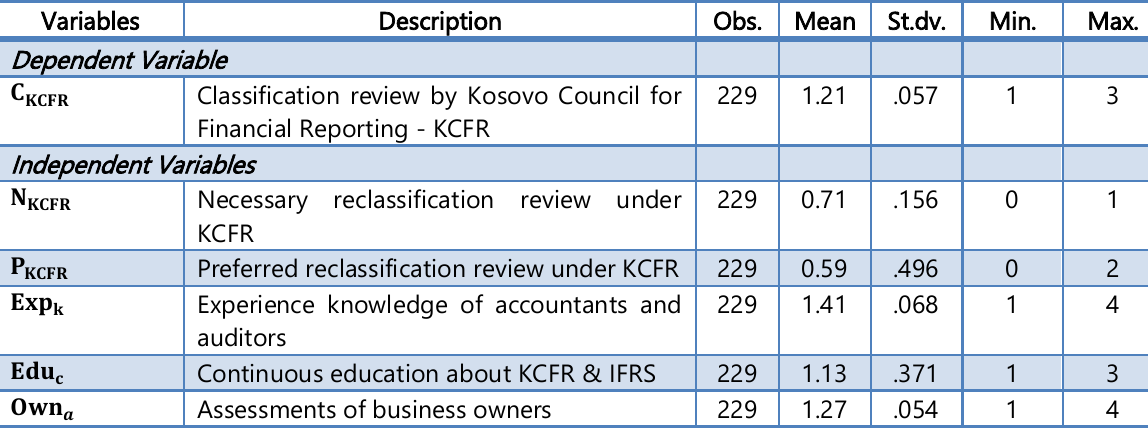
Table 2: Variable and Statistics Description (Source: Authors‟ calculation) Variables Description Obs. Mean St.dv. Min.